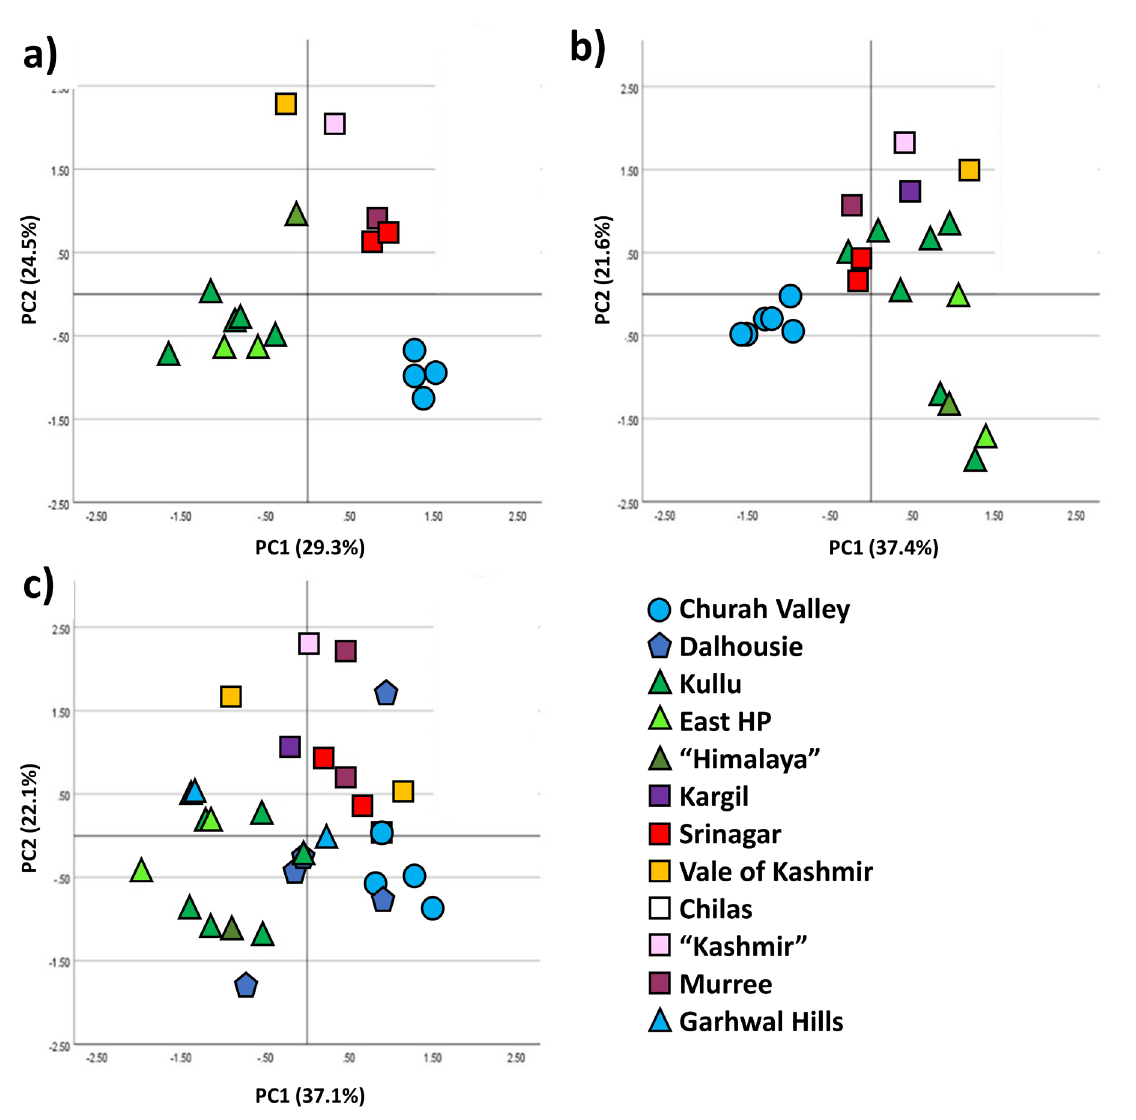
Fig. 5. Principal components analysis of Gloydius himalayanus (Günther, 1864) morphological